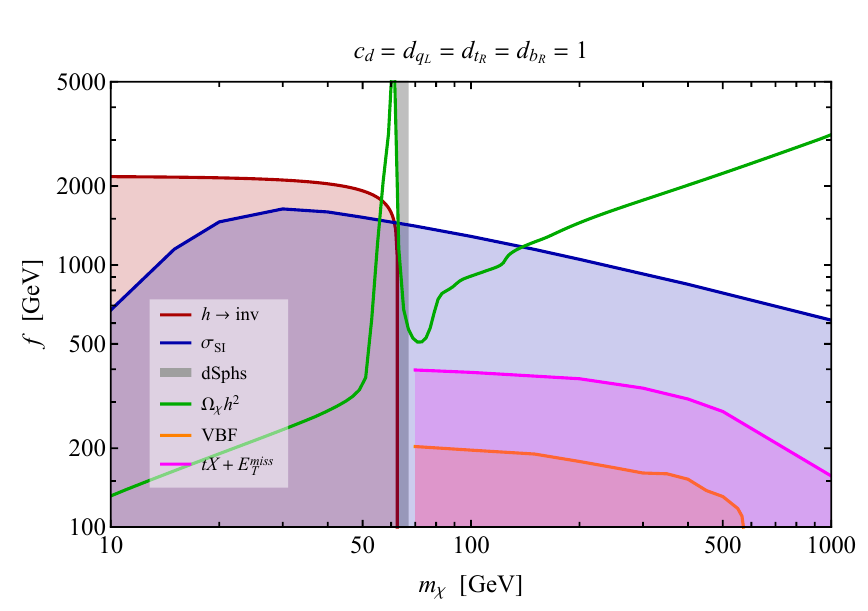
Figure 8 . As figure 7 but for the pNGB DM benchmark model with c d = d q